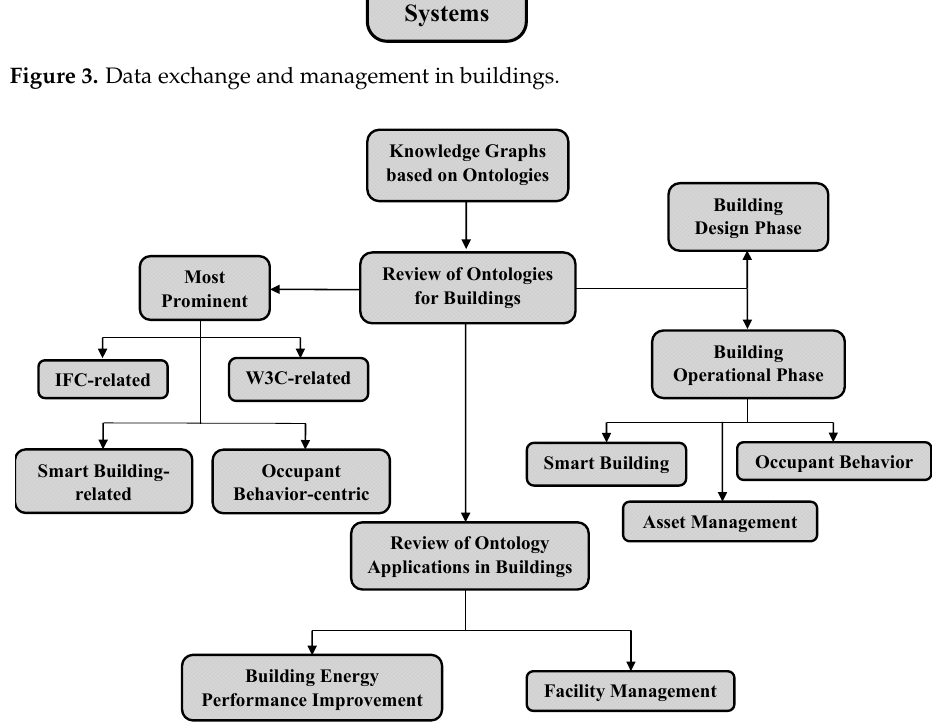
Figure 4. Methodology schema followed for the